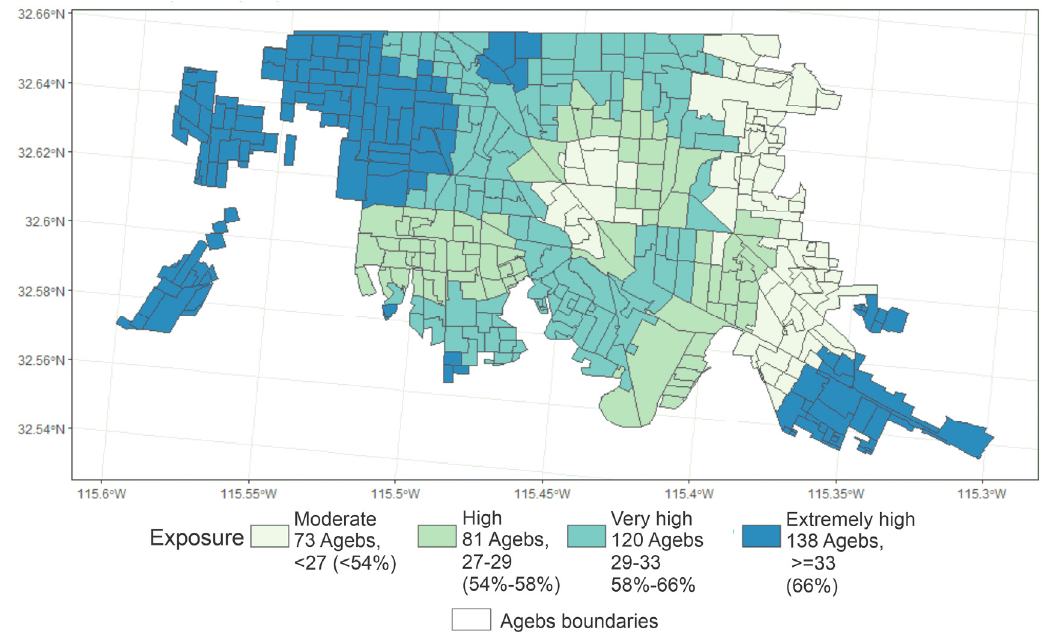
Figure 2. Exposure areas by exceedance days in the urban areas of Mexicali, B.C., at the basic geo-statistical area (AGEB by its acronym in Spanish) level. Parentheses are the percentages of exceedances in days based on 50 days as the maximum measurements available in all the monitoring stations during 2015—categories by quartiles.